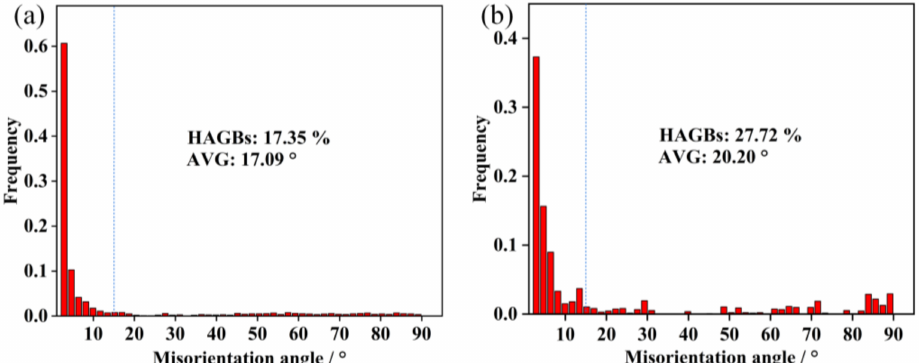
Figure 10. ( a ) Distribution of grain boundary misorientation for Ti-55511 alloy deformed to a strain of 0.83 at 750 °C and ( b ) annealed at 775 °C for 30 min.